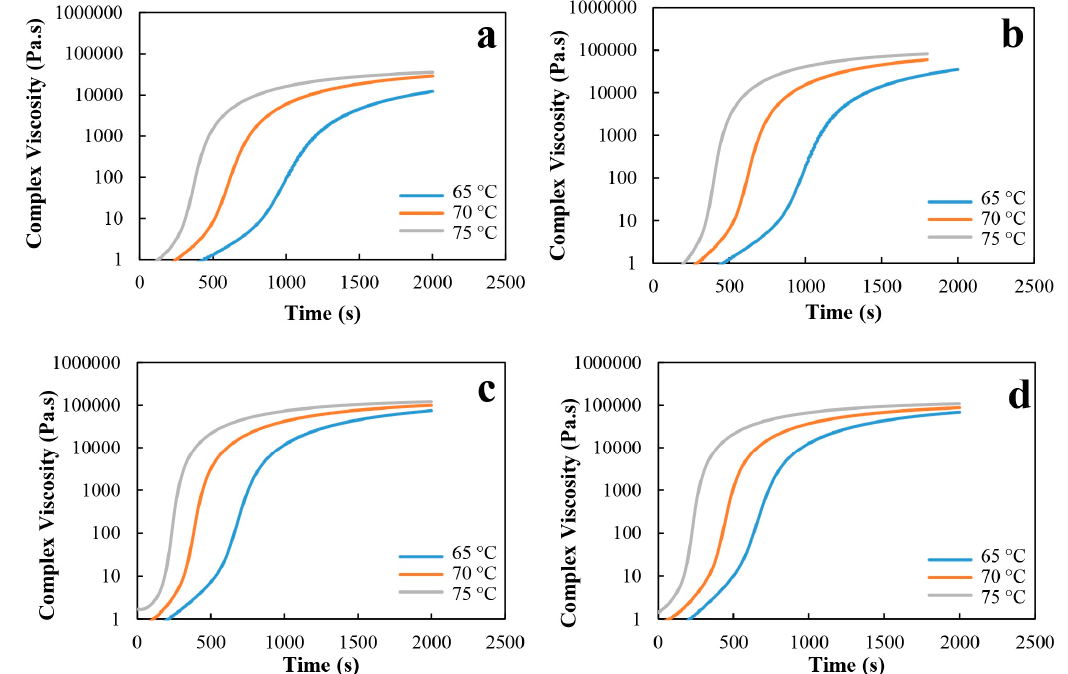
Figure 5. The complex viscosity versus time at different temperatures of 65, 70 and 75 ◦ C for ( a ) epoxy resin, ( b ) epoxy resin/0.5% UFNBRP ( c ) epoxy resin/1% UFNBRP and ( d ) epoxy resin/1.5%